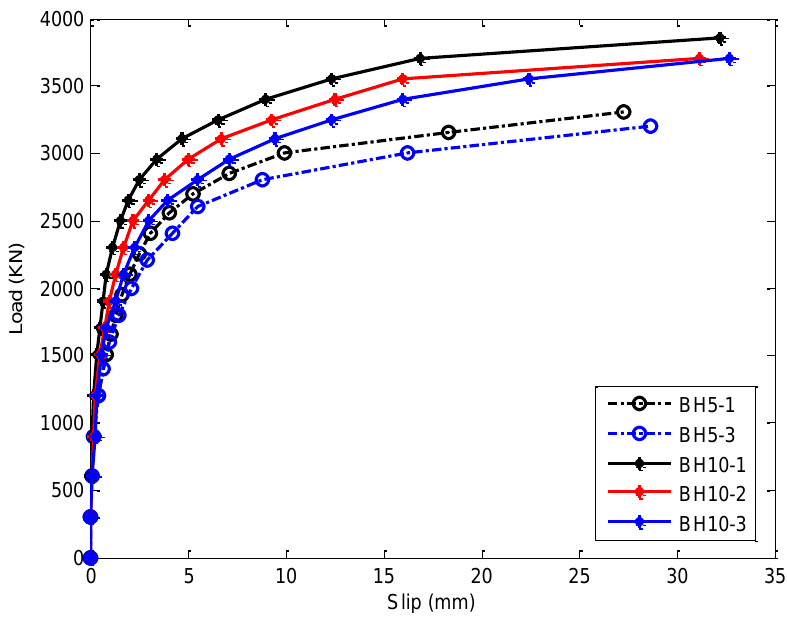
Figure 13. Load–slip relationship. Figure 13. Load – slip relationship.